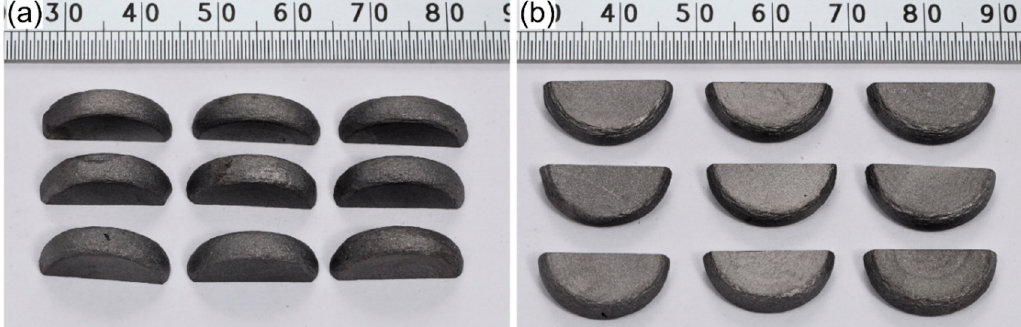
Figure 7. Photographs of ( a ) side view and ( b ) top view of the Ti-6Al-4V swarf specimens consolidated via FAST at 1200 ◦ C for 30 min after a subsequent hot compression at 950 ◦ C (top row), 900 ◦ C (middle row), and 850 ◦ C (bottom row), and a strain rate of 0.01 s − 1 (left column), 0.1 s − 1 (middle column), and 1 s − 1 (right column). The deformed specimens have been abrasively sectioned in half to allow metallographic preparation.